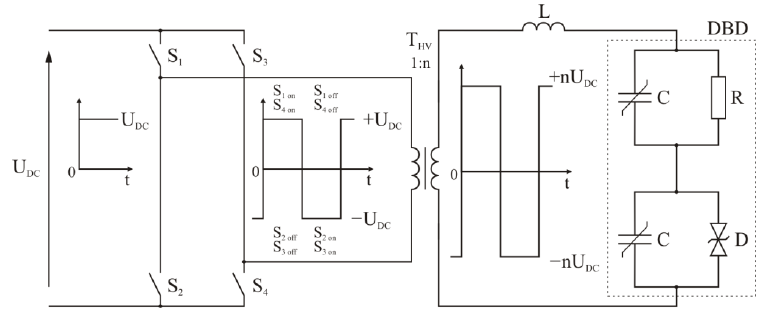
Figure 12. Resonant converter topology for DBD plasma reactor [56].